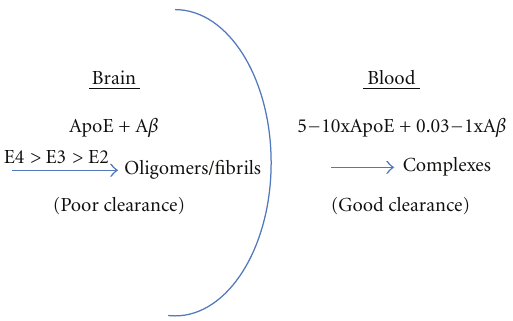
Figure 1: ApoE promotes A β Fibril formation in brain and A β clearance from the blood. Data from both in vitro and in vivo experiments indicate that apoE, especially apoE4 promotes the polymerization of A β into oligomers and polymers that accumulate in the brain and are di ffi cult to clear. In contrast, the concentration of apoE is higher in the blood, while those of A β species are equivalent to or lower than in the brain, promoting the formation and clearance of equimolar apoE-A β